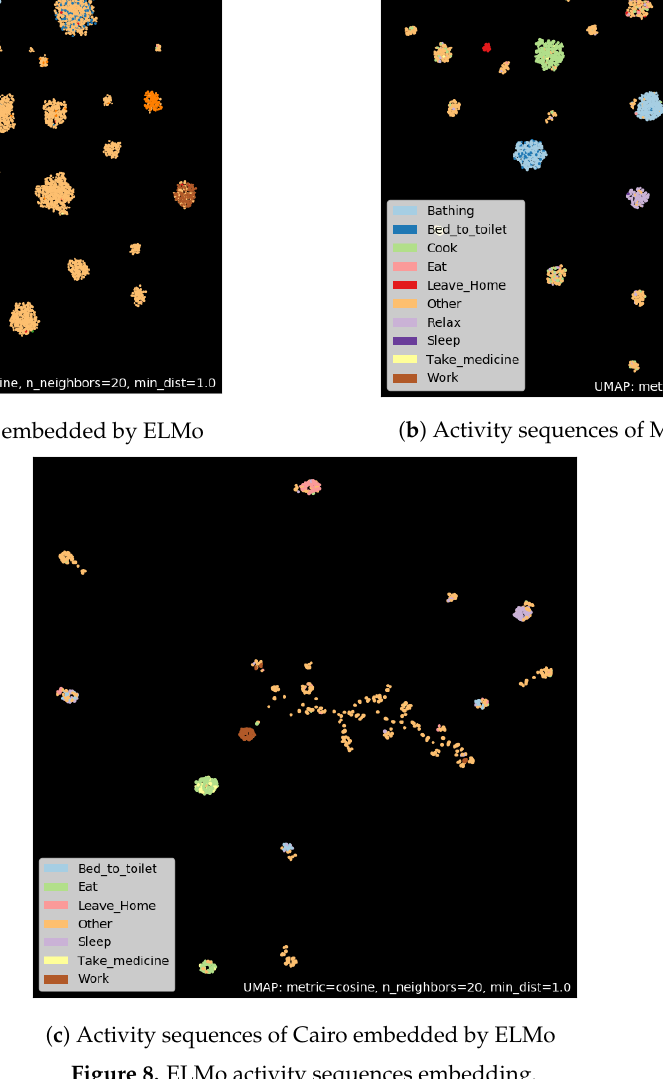
Figure 8. ELMo activity sequences